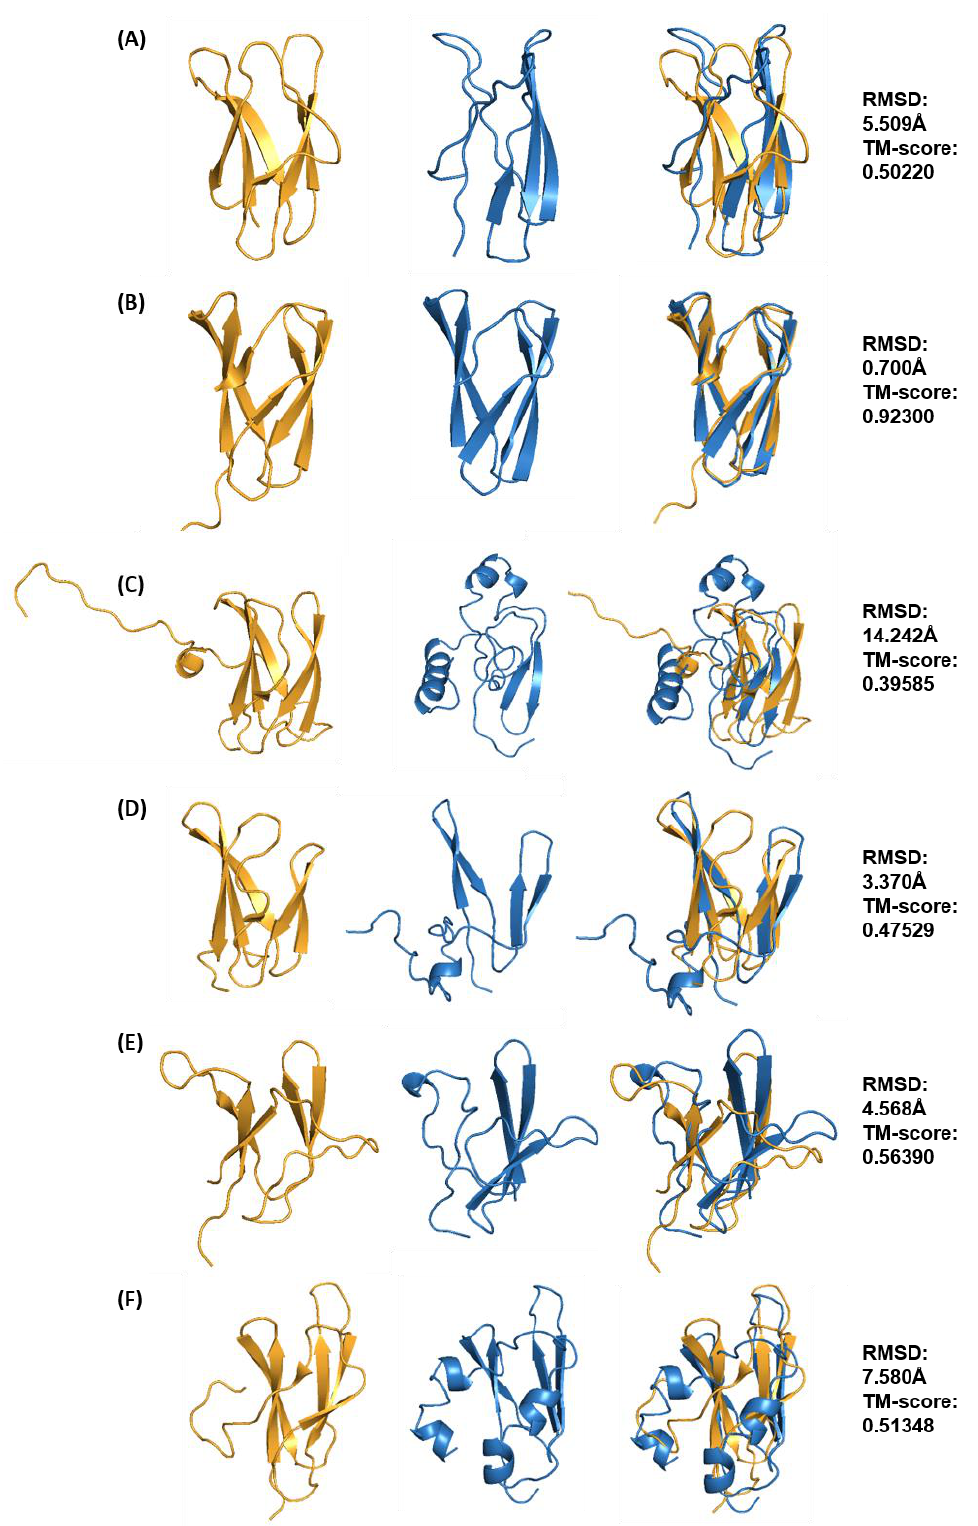
Figure 6. Best structural models for MAX effector templates ToxB ( A ), AvrPib ( B ), AvrPik ( C ), Avr1CO39 ( D ), AvrPia ( E ) and AvrPiz-t ( F ) predicted with Rosetta ab initio modelling. All models are shown in blue in ribbon representation, and each model was superimposed onto their respective XRD or NMR template structure (shown in gold). RMSD and TM-score values are shown on the right-hand